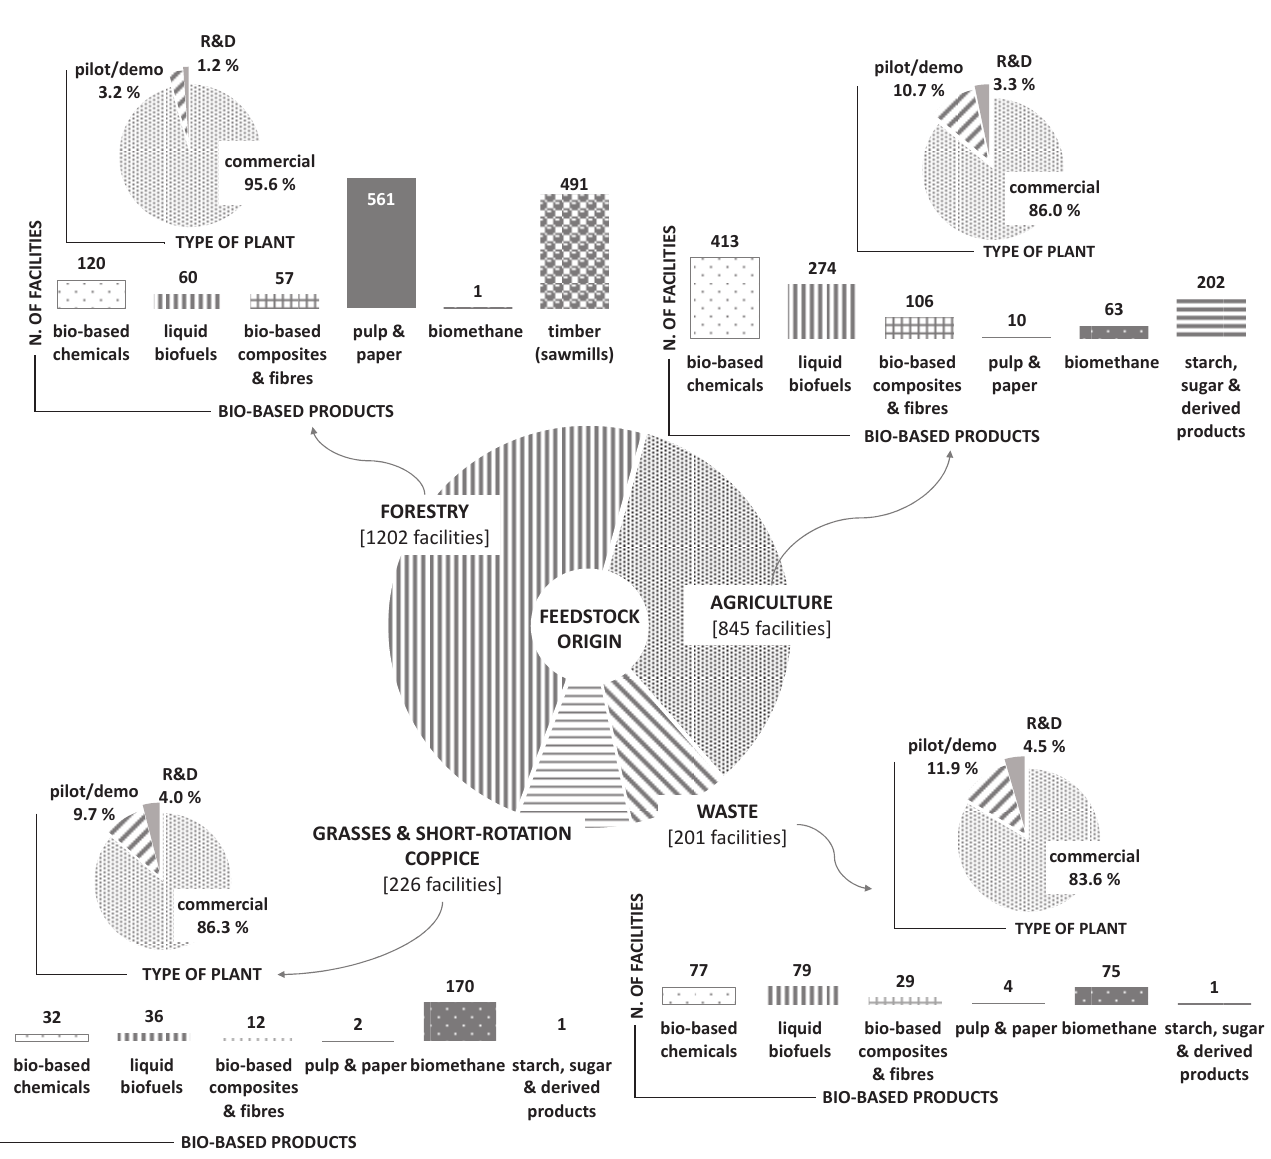
Fig. 7 – Production of bio-based products from lignocellulosic biomass at industrial, pilot-scale and laboratory level in European